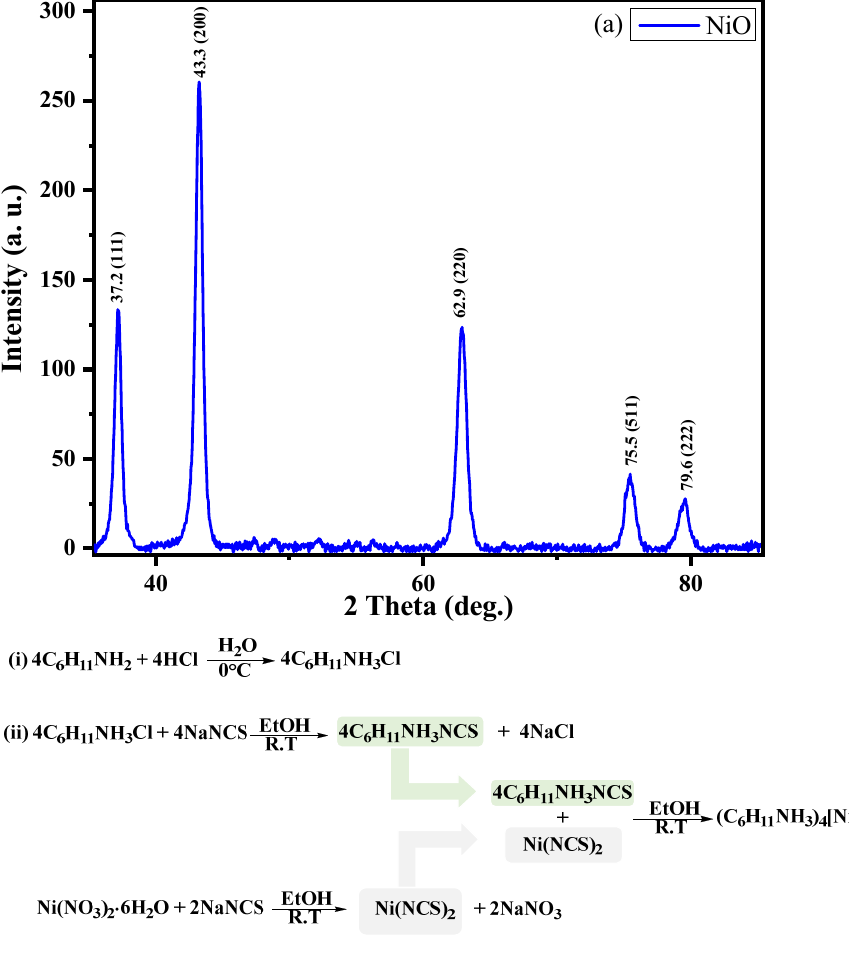
Figure 10. XRD patterns of ( a ) NiO and ( b ) NiS, obtained after the pyrolysis of